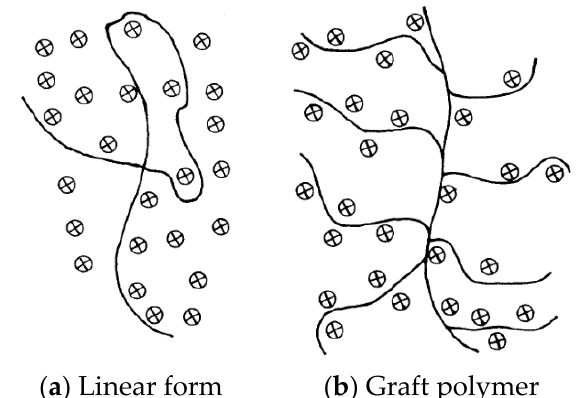
Figure 2. ( a ) Linear polymer represents the coil form bound to the oppositely charged particles, while ( b ) is the graft polymer presenting the comb form, able to bind to a large number of oppositely charged particles in the solution [83].